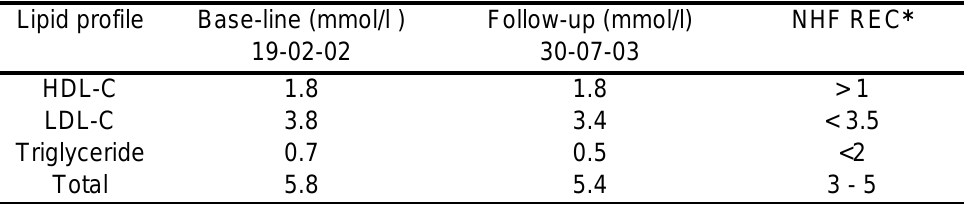
Details of the Blood Cholesterol Tests at Two Time